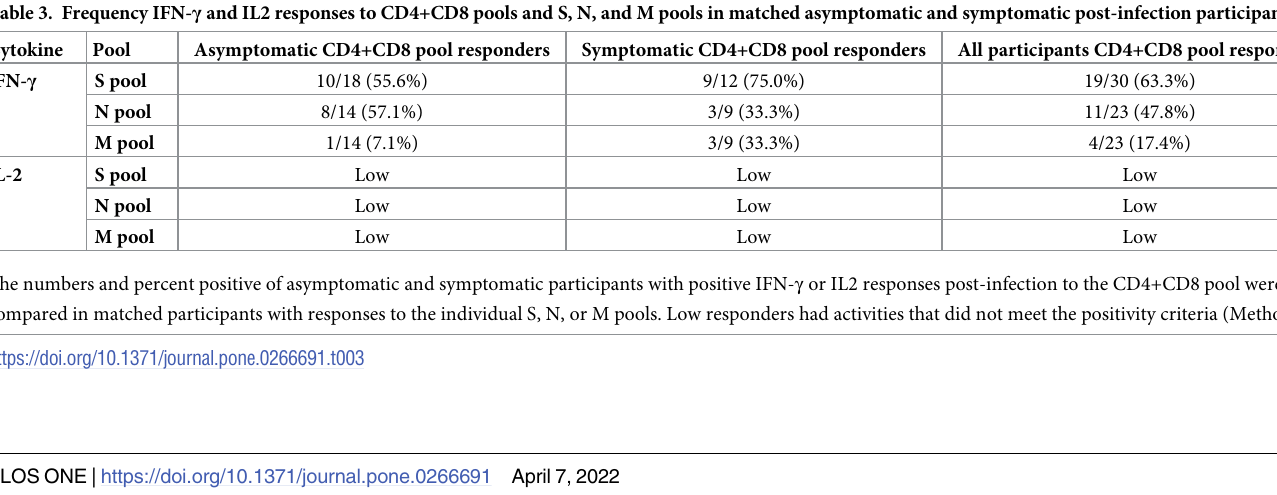
Table 3. Frequency IFN- γ and IL2 responses to CD4+CD8 pools and S, N, and M pools in matched asymptomatic and symptomatic post-infection participants. Cytokine Pool